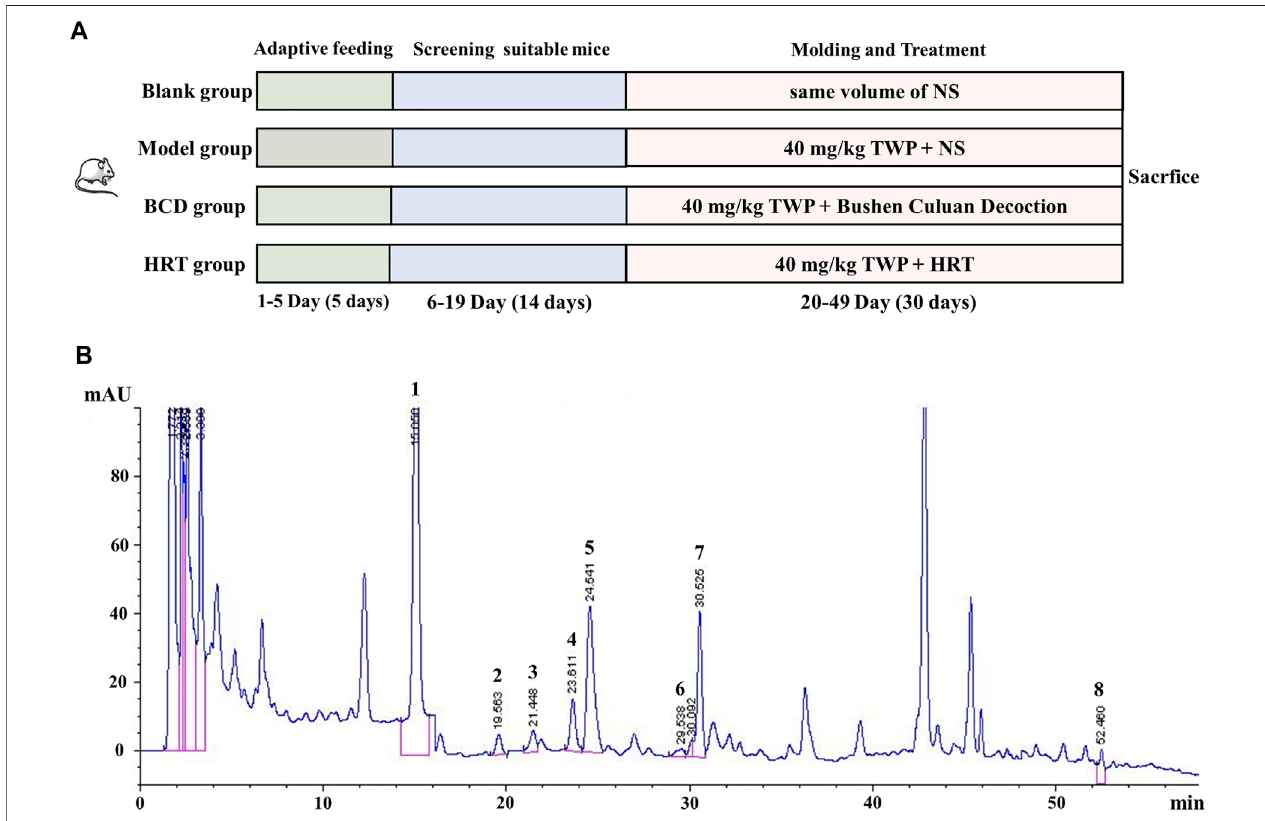
FIGURE 1 | The experimental schema and representative HPLC chromatogram of BCD. (A) POI mouse model development and treatment protocol. (B) HPLC analysis of BCD: Mobile phase was acetonitrile/ultrapure water (containing 0.1% phosphoric acid) gradient for 60 min with a fl ow of 1 ml/min. Peaks: 1. peoni fl orin, 2. ferulic acid, 3. typhaneoside, 4. hyperoside, 5. isorhamnetin-3-O-neohesperidoside, 6. specnuezhenide, 7. cyasterone and 8. asperosaponin